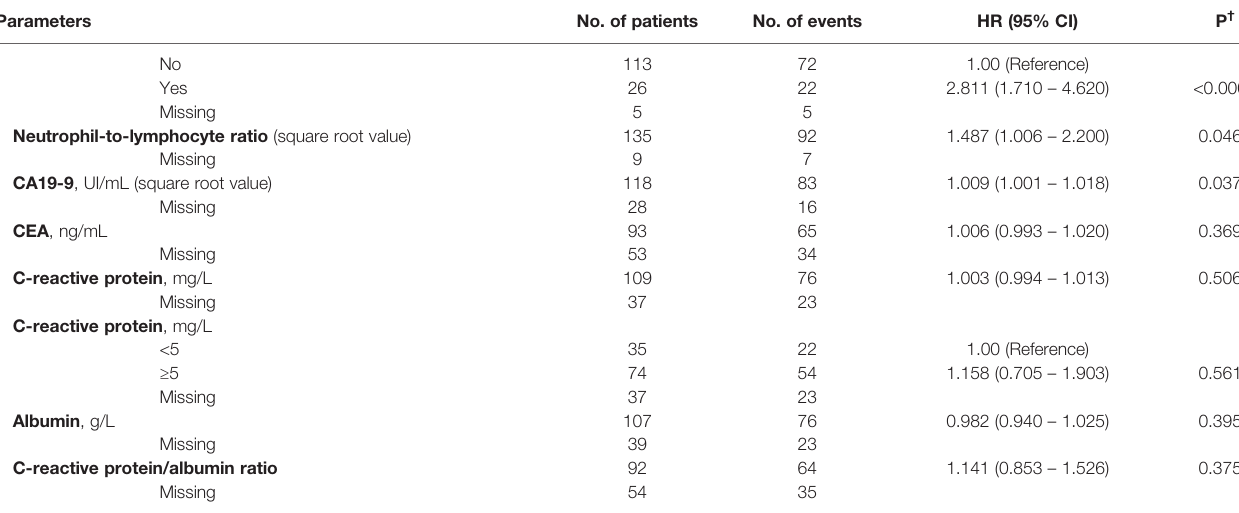
TABLE 3 | Preoperative prognostic factors associated with relapse-free survival in multivariable analysis (N = 72) Parameters Tumor size ,